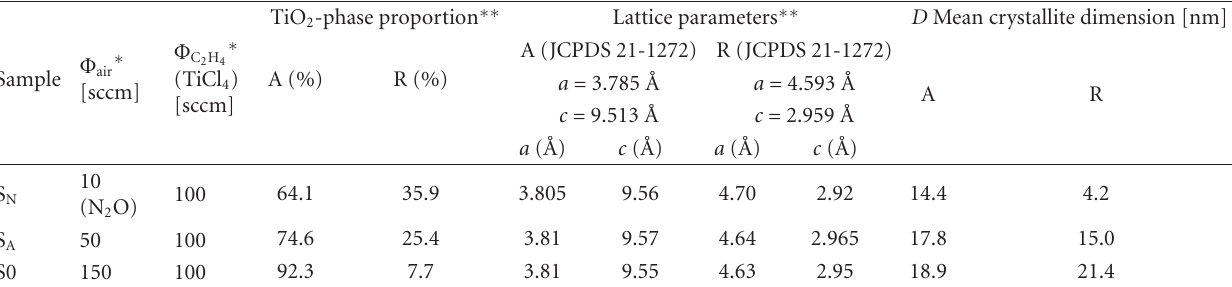
Table 2: Synthesis parameters and crystallographic parameters of nanoTiO 2 particles.